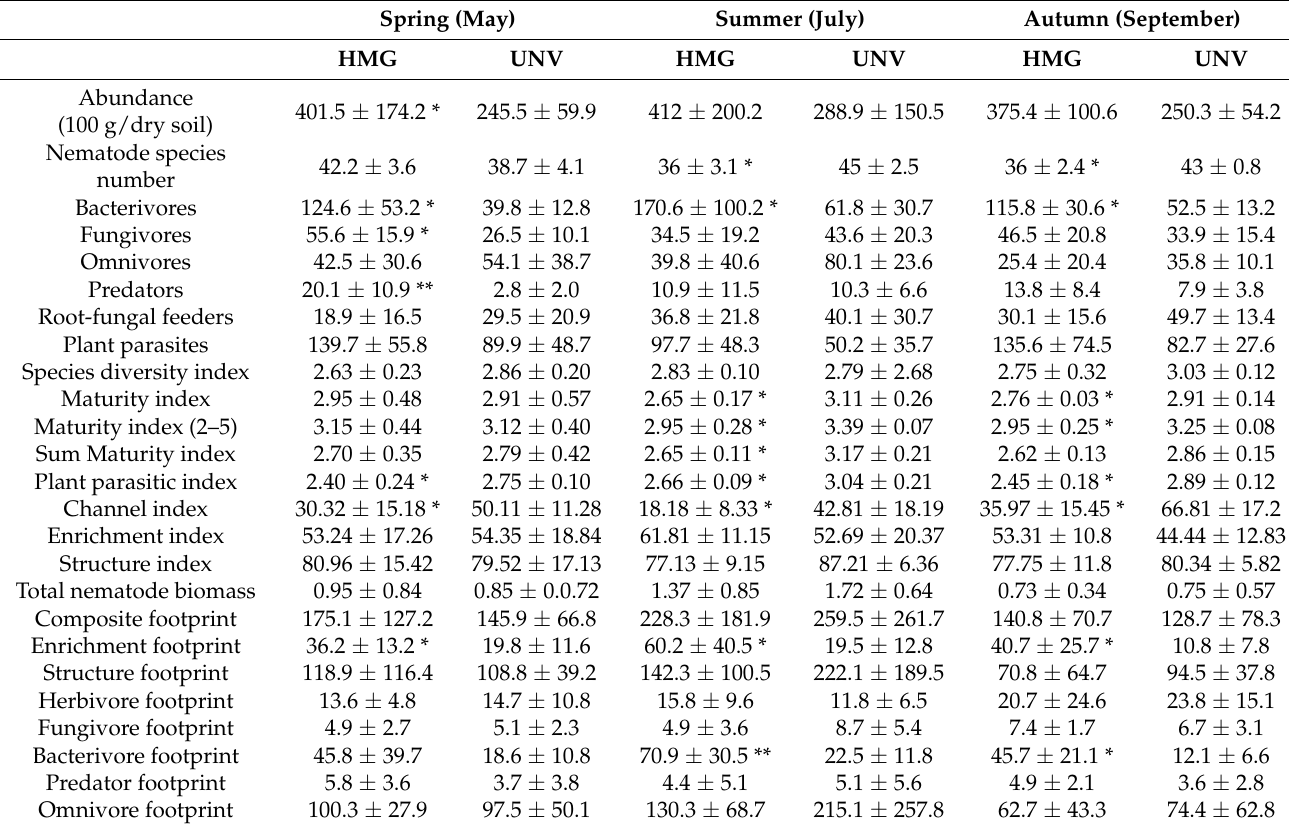
Table 4. Mean values ( ± S.D.) for nematode abundance, species number, trophic groups, and community descriptors of investigated plots of Heracleum mantegazzianum invaded and uninvaded control plots in the three vegetation seasons and two years of 2017 and